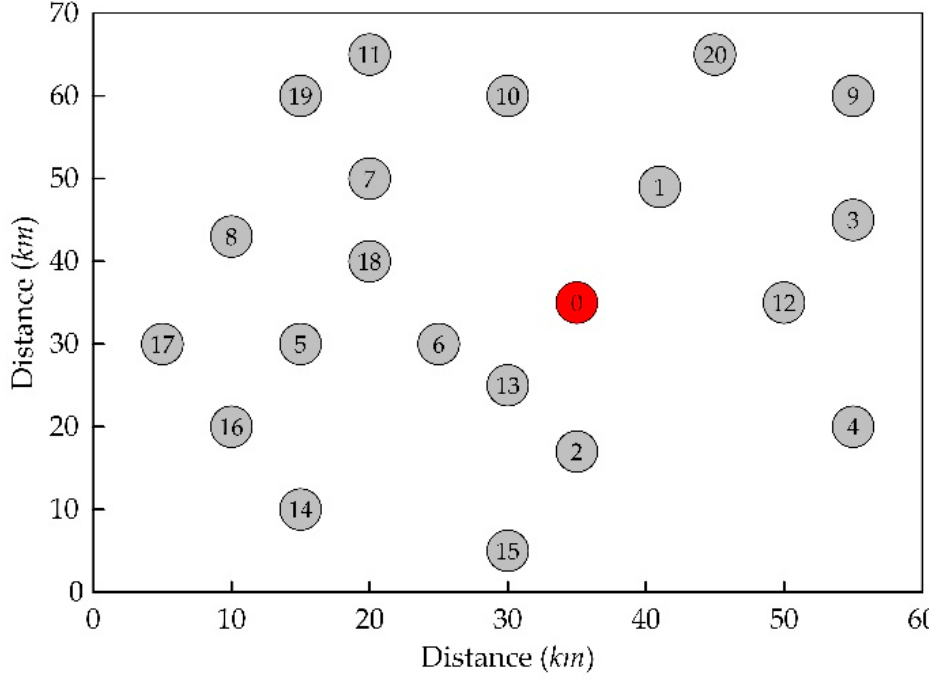
Figure 5. Schematic diagram of spatial coordinates of tomato farm and consumers.